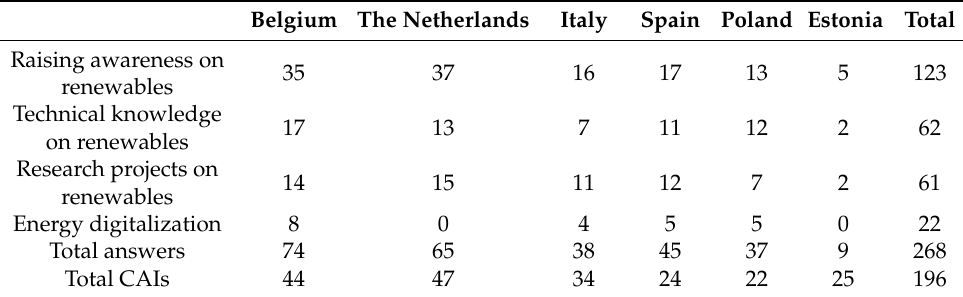
Table 13. Knowledge and skill